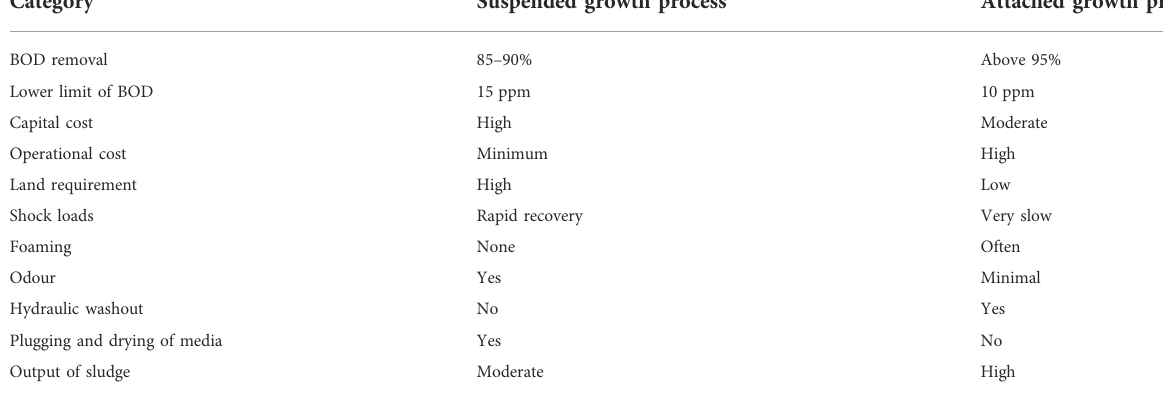
TABLE 3 Comparison of suspended growth process and attached growth process.